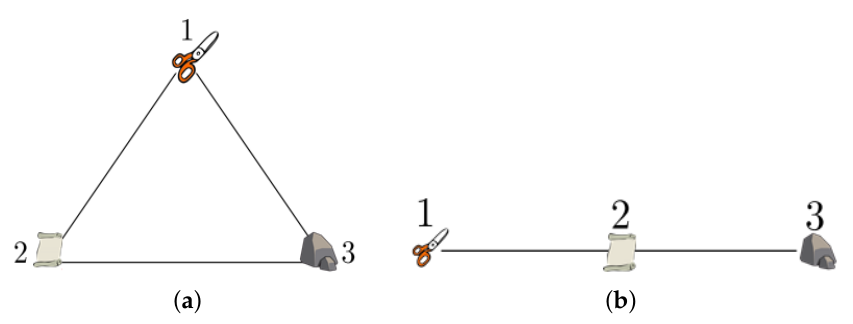
Figure 3. Example of graphs for ( a ) full-well-mixed population and ( b ) non-full-well-mixed